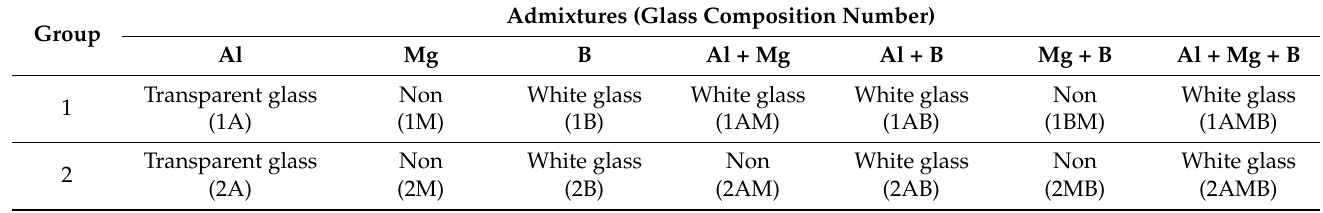
Table 2. Influence of the different admixtures on the vitrification in the system investigated: